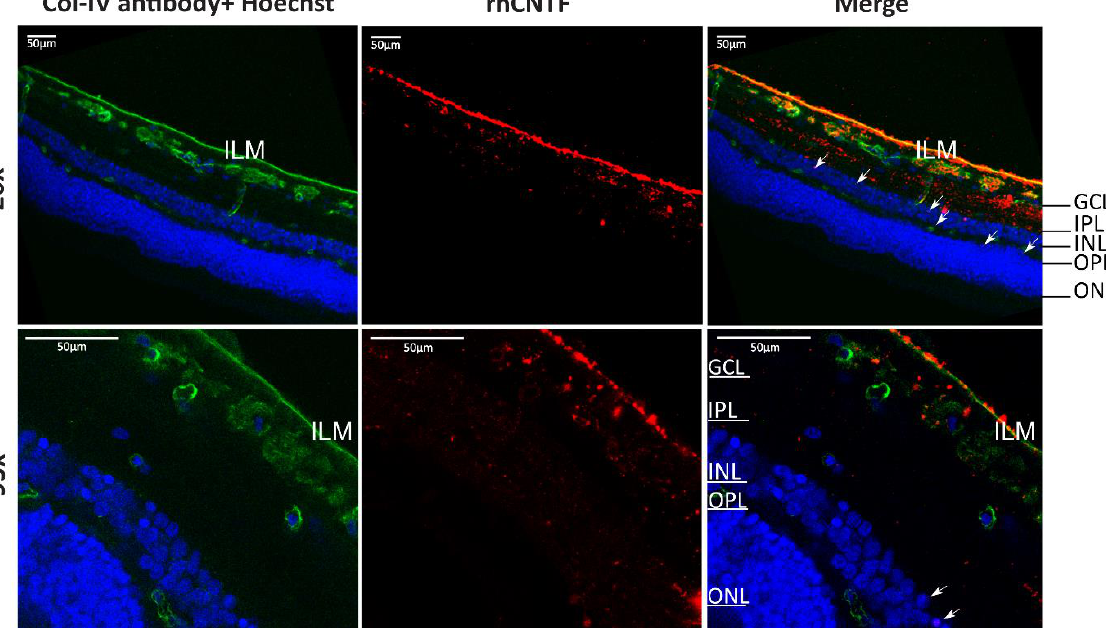
Figure 15. rhCNTF penetration in bovine retinal explant. NT-647 labeled rhCNTF (red) readily penetrates across inner limiting membrane (ILM) and distributes in the retina after apical administration, with evident fluorescence observed in the neural retina in layers ranging from ganglion cell layer (GCL) to outer plexiform layer (OPL). ILM, inner limiting membrane; GCL, ganglion cell layer; IPL, Inner plexiform layer; INL, inner nuclear layer; OPL, outer plexiform layer; ONL, outer nuclear layer.